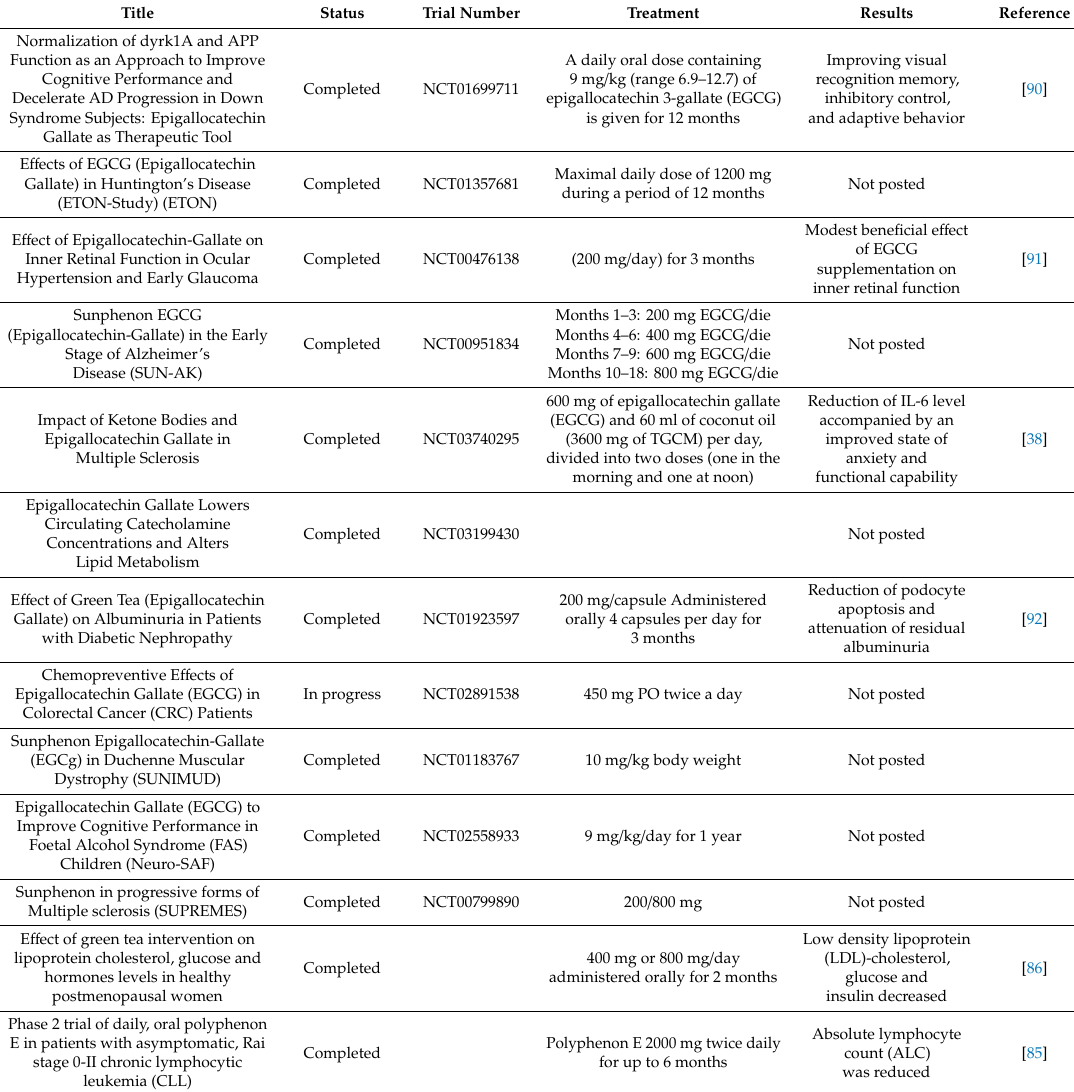
Table 1. Clinical Trials on